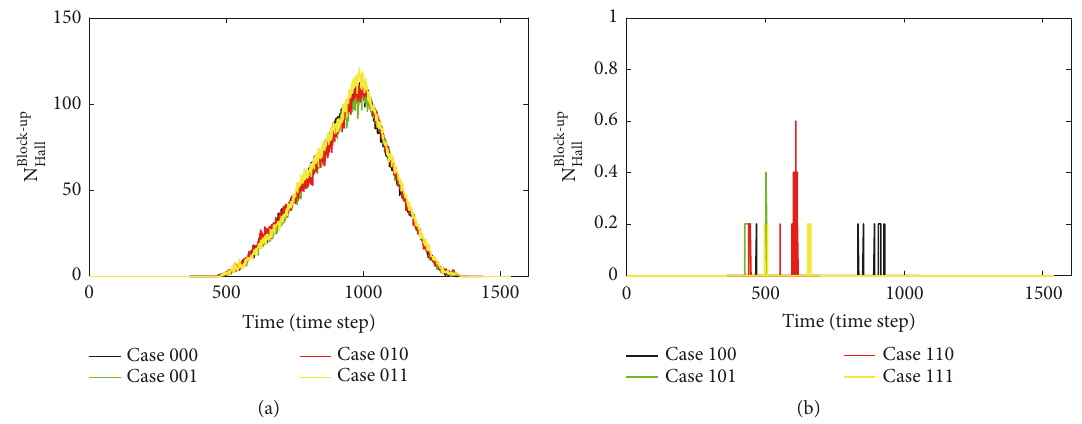
Figure 11: Relationship between 𝑁 Block-up Hall and time under the eight